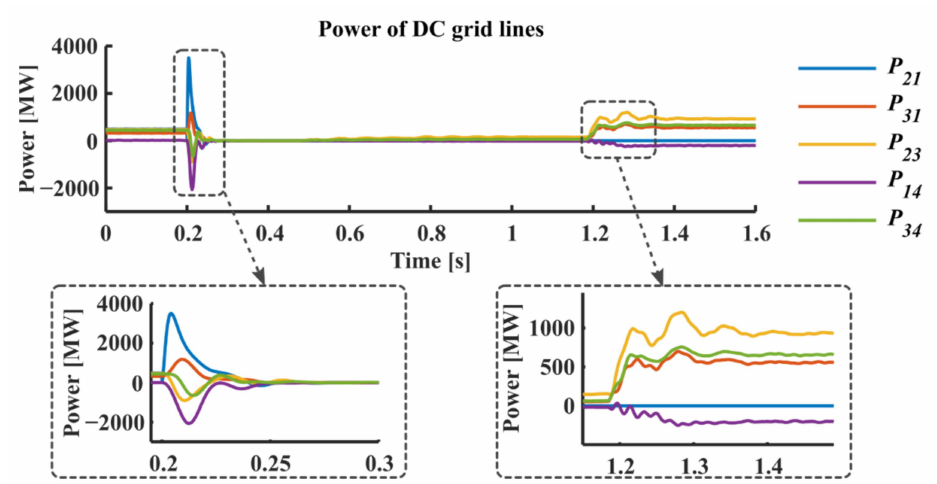
Figure 20. Power flow in the DC transmission lines with fault at location F3.